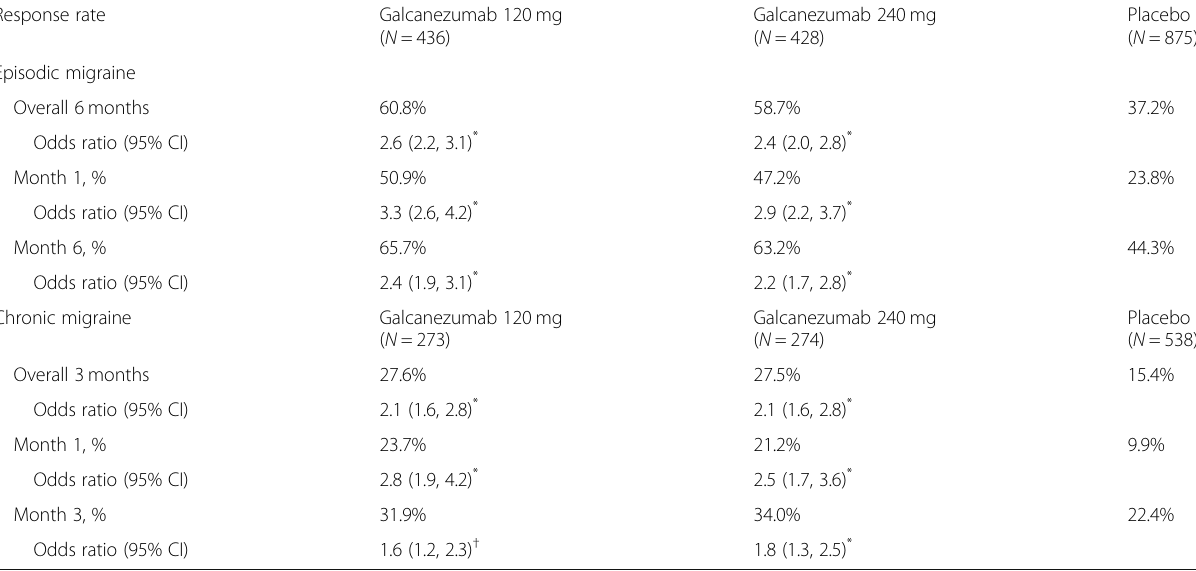
Table 2 Model-estimated proportion of patients with episodic and chronic migraine with ≥ 50% response Response